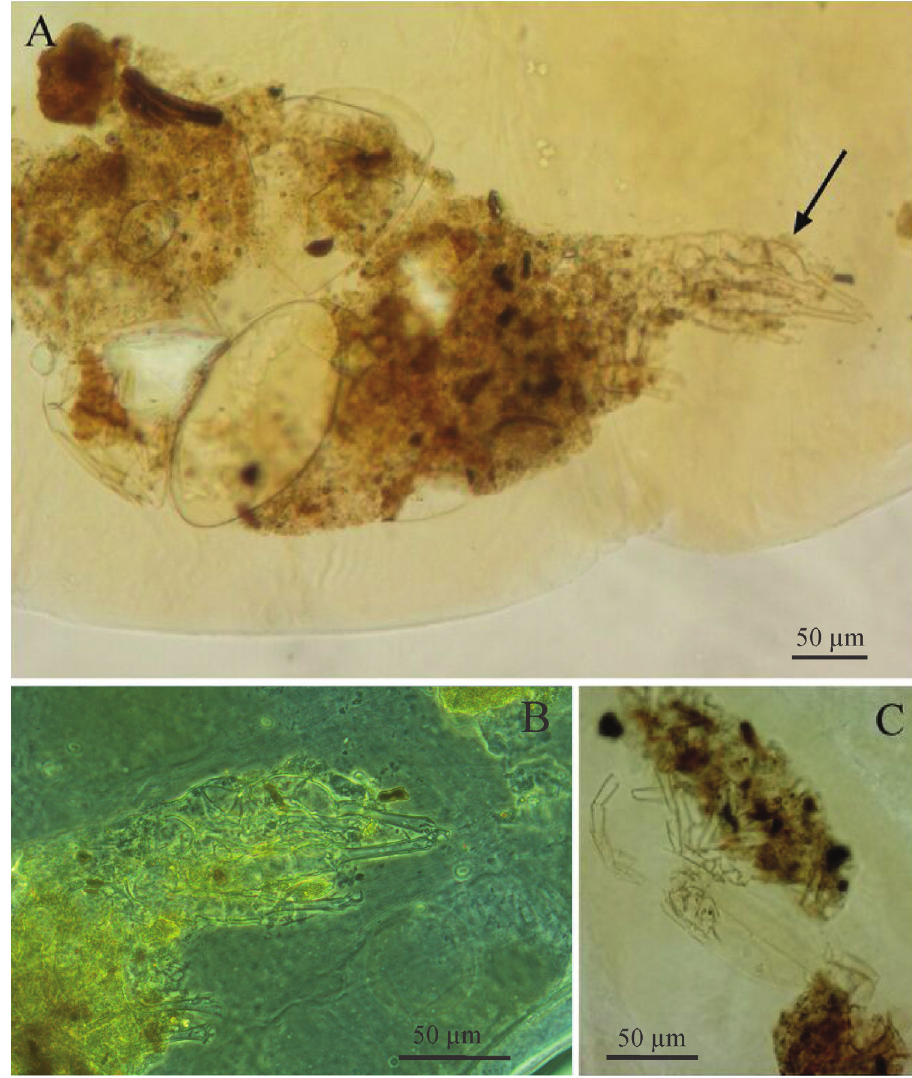
Figure 4. A General view of gut contents from a specimen of Tanypodinae (Chironomidae), where the arrow shows an specimen of Tyrophagus sp. (Acariformes: Sarcoptiformes: Acaridae) among alimentary items B Detail view of the partially digested Tyrophagus sp. C Detail of specimen already partially digested which possibly belongs to the family Frontipodopsidae (Acariformes: